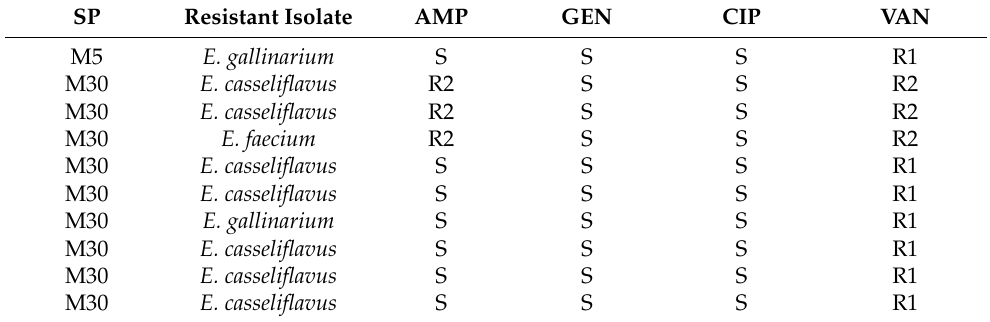
Table 9. Antibiotic-resistant profiles of isolated resistant enterococci against selected types of antibiotics. SP Resistant Isolate AMP GEN CIP VAN M5